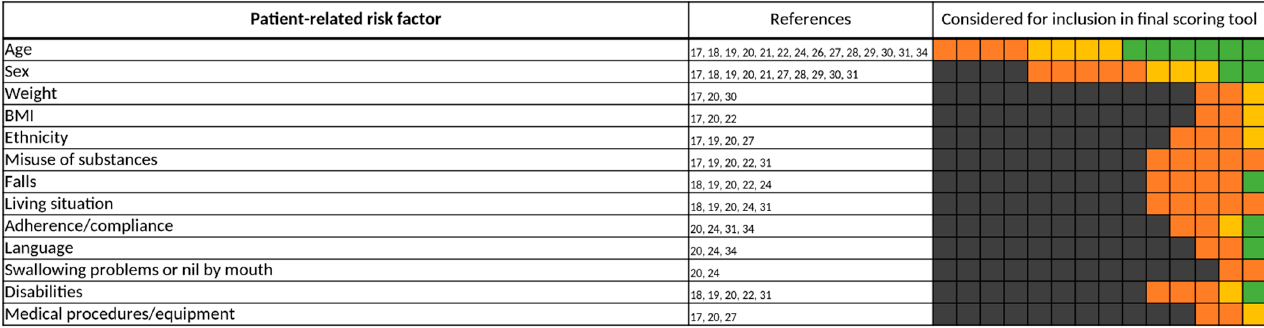
Figure 10. Patient-related risk factors. Each of the 14 boxes represents one of the included studies. The color of the boxes portrays whether a risk factor was not investigated in a study (gray), was investigated (orange), was significant in a first statistical analysis or based on expert consensus and therefore tested for inclusion in a final scoring tool (yellow), or whether a risk factor was included in a final scoring tool (green). The “citations”-column lists each study that at least investigated the respective risk factor.